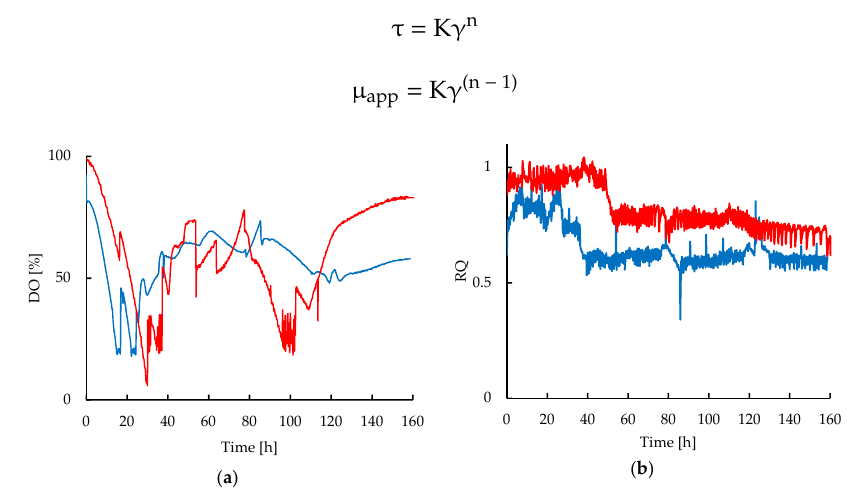
Figure 3. Dynamic profiles of oxygen in liquid and exhaust gas in fed-batch cultivations of S. clavuligerus : ( a ) Dissolved oxygen (DO) in STR (blue) and CT (red) cultivations; ( b ) Respiratory Quotient (RQ) in STR (blue) and CT (red) cultivations.